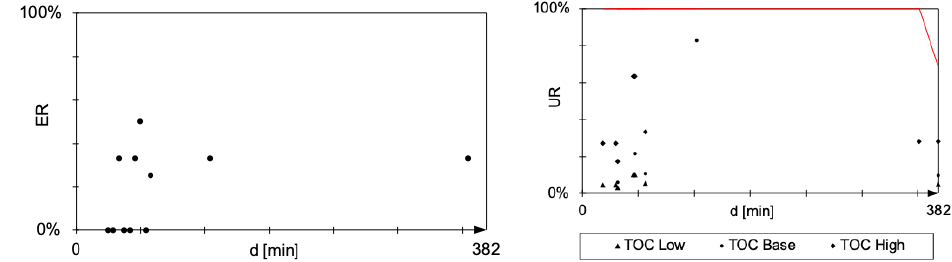
Figure 6. Success rate ER ( left ) and rebooking rate UR ( right ) of compensating reactionary delay by rebooking passengers ( REBP ). The solid red line represents the seat load factor SLF of the alternative